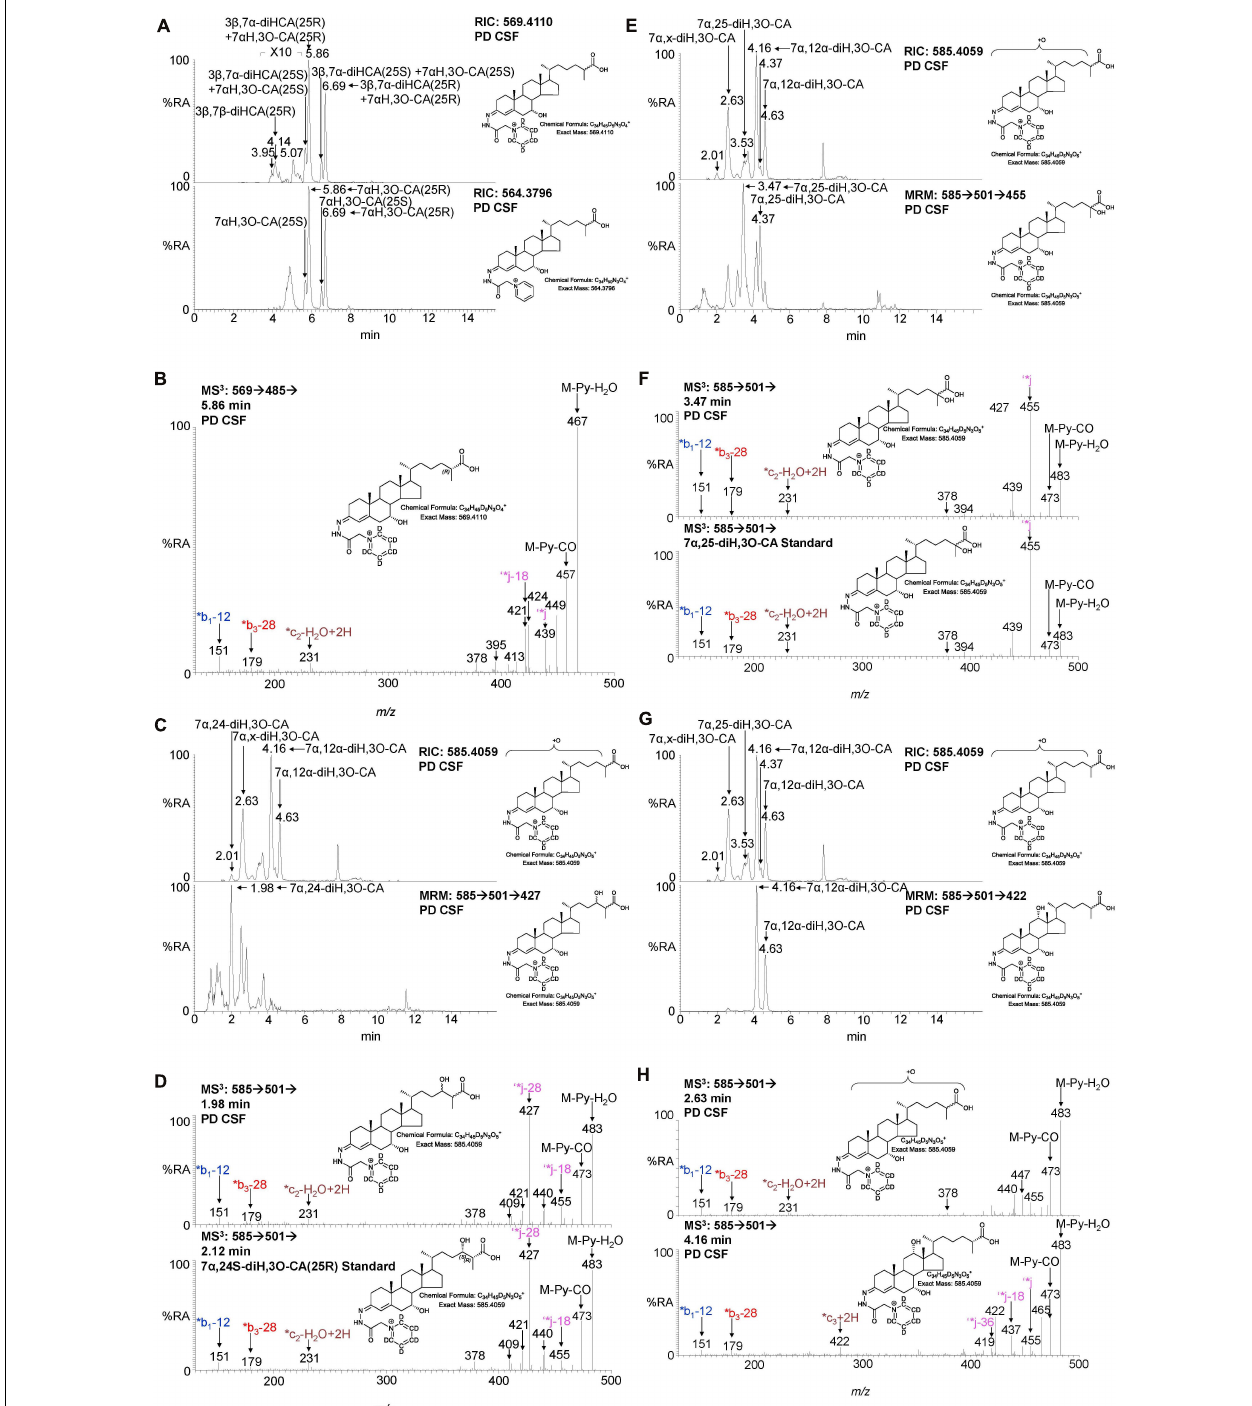
FIGURE 4 | LC-MS(MS n ) analysis of cholestenoic acids found in CSF. (A) RIC of m/z 569.4110 ± 5 ppm revealing 3 β ,7 β -diHCA and 3 β ,7 α -diHCA (upper panel) and of 564.3796 ± 5 ppm revealing 7 α H,3O-CA (lower panel). Each acid is present as two epimers, and each epimer gives syn and anti conformers of the GP-derivative. (B) MS 3 (M + → M + -Py → ) spectrum of 3 β ,7 α -diHCA(25R). (C,E,G) RIC of m/z 585.4059 ± 5 ppm revealing dihydroxy-3-oxocholestenoic acids (upper panels) and MRM-like chromatogram 585.4 → 501.3 → 427 highlighting 7 α ,24-diH,3O-CA (lower panel C), 585.4 → 501.3 → 455 highlighting 7 α ,25-diH,3O-CA (lower panel E) and 585.4 → 501.3 → 422 highlighting 7 α ,12 α -diH,3O-CA (lower panel G). MS 3 (M + → M + -Py → ) spectra of (D) 7 α ,24-diH,3O-CA in CSF (upper panel) and 7 α ,24S-diH,3O-CA(25R) authentic standard (lower panel), (F) 7 α ,25-diH,3O-CA in CSF (upper panel) and 7 α ,25-diH,3O-CA authentic standard (lower panel), and (H) 7 α ,x-diH,3O-CA (upper panel) and 7 α ,12 α -diH,3O-CA (lower panel) in